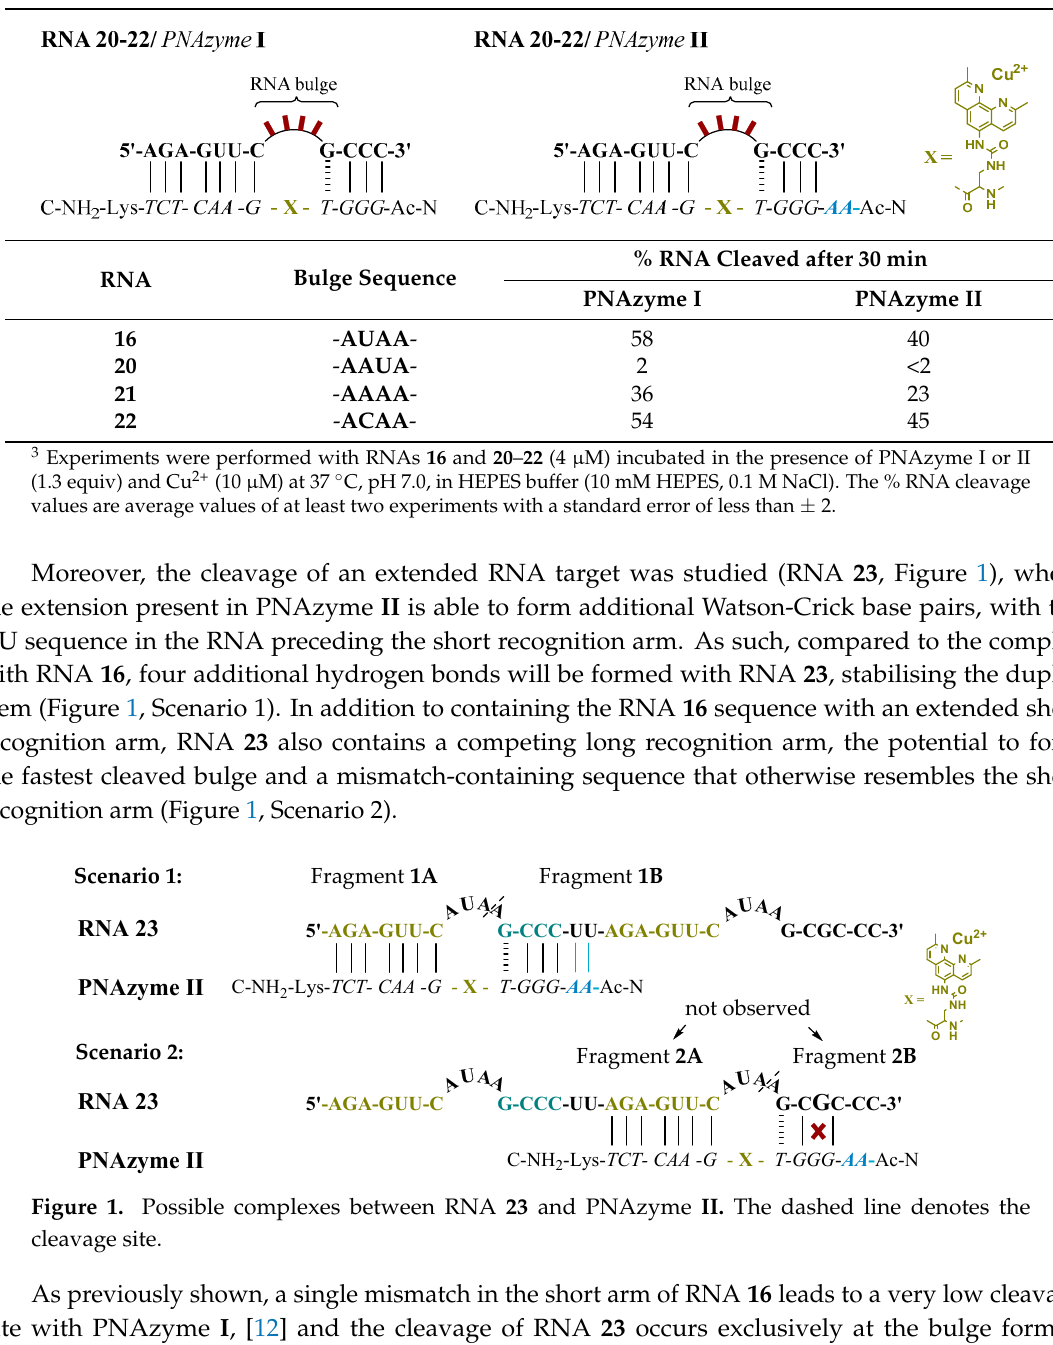
Figure 1. Possible complexes between RNA 23 and PNAzyme II. The dashed line denotes the cleavage site.